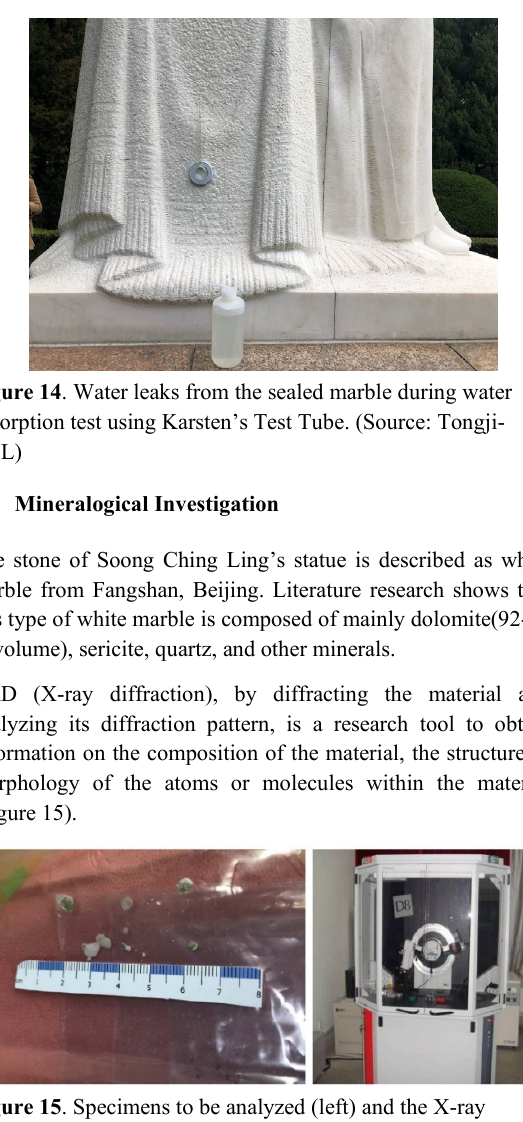
Figure 13 . Laboratory analysis of the chalking evaluation test. (Source: Tongji-ACL)